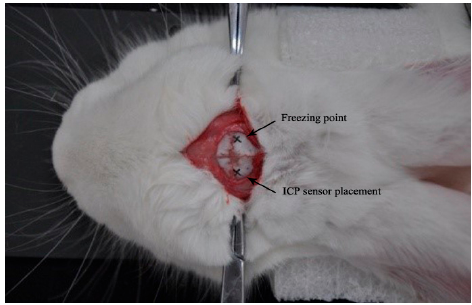
Figure 3. Rabbit freezing point and ICP sensor placement.